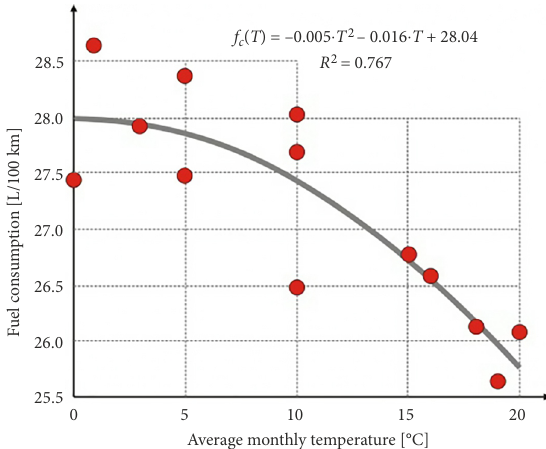
Figure 7. FC as a function of average monthly temperature